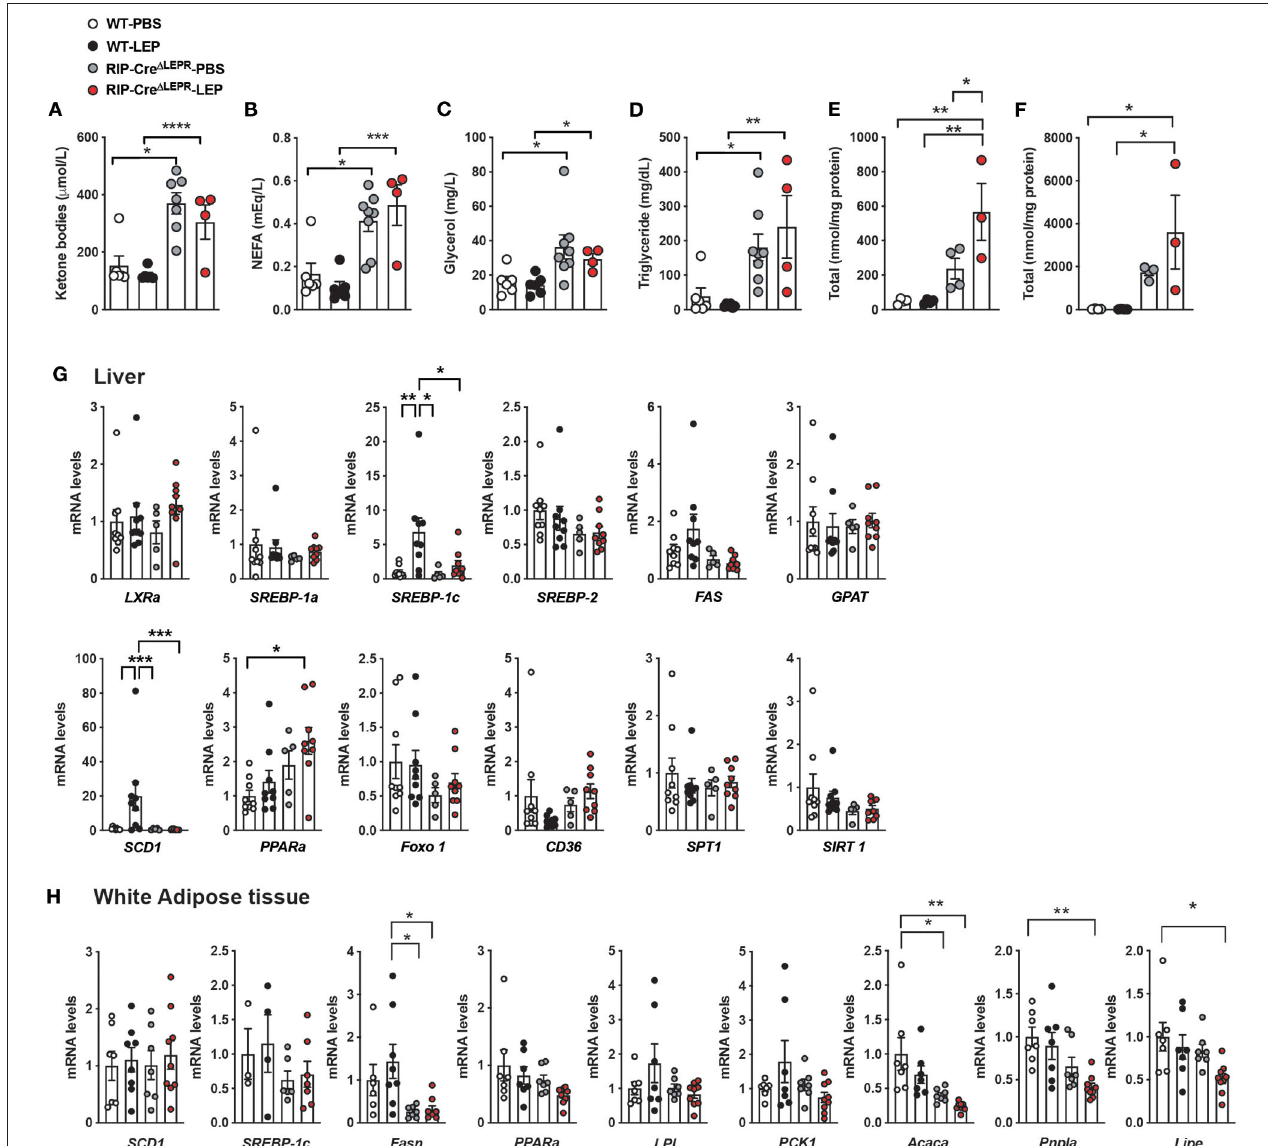
FIGURE 5 | LEPRs in RIP-Cre 25Mgn neurons mediate anti-dyslipidemia effects of leptin in insulin-deficient mice. (A) Plasma ketone bodies ( n = 6; WT-PBS, 6; WT-LEP, 4; RIP-Cre 1 LEPR -PBS, and 7; RIP-Cre 1 LEPR -LEP), (B) non-esterified fatty acids (NEFA) ( n = 6; WT-PBS, 6; WT-LEP, 4; RIP-Cre 1 LEPR -PBS, and 8; RIP-Cre 1 LEPR -LEP), (C) Glycerol ( n = 6; WT-PBS, 6; WT-LEP, 4; RIP-Cre 1 LEPR -PBS, and 8; RIP-Cre 1 LEPR -LEP), (D) TG ( n = 6; WT-PBS, 6; WT-LEP, 4; RIP-Cre 1 LEPR -PBS, and 8; RIP-Cre 1 LEPR -LEP), (E) hepatic total FFAs level ( n = 4; WT-PBS, 4; WT-LEP, 4; RIP-Cre 1 LEPR -PBS, and 3; RIP-Cre 1 LEPR -LEP), (F) hepatic total TG levels ( n = 4; WT-PBS, 4; WT-LEP, 4; RIP-Cre 1 LEPR -PBS, and 3; RIP-Cre 1 LEPR -LEP) of insulin-deficient RIP-Cre 1 LEPR mice administered leptin into the lateral ventricle (25 ng/0.11 µ L/h). Blood and tissue samples were collected 10 days after the induction of chronic administration of leptin into the lateral ventricle. mRNA levels of genes related to lipid metabolism in (G) liver ( n = 9; WT-PBS, 9; WT-LEP, 5; RIP-Cre 1 LEPR -PBS, and 9; RIP-Cre 1 LEPR -LEP) and (H) perigonadal white adipose tissue ( n = 4–7; WT-PBS, 4–8; WT-LEP, 6–7; RIP-Cre 1 LEPR -PBS, and 6–9; RIP-Cre 1 LEPR -LEP). Control groups were administered sterile PBS. Values are mean ± S.E.M. **** p < 0.0001, *** p < 0.001, ** p < 0.01, * p < 0.05. One way ANOVA followed by Tukey’s multiple comparison test was used to analyze the